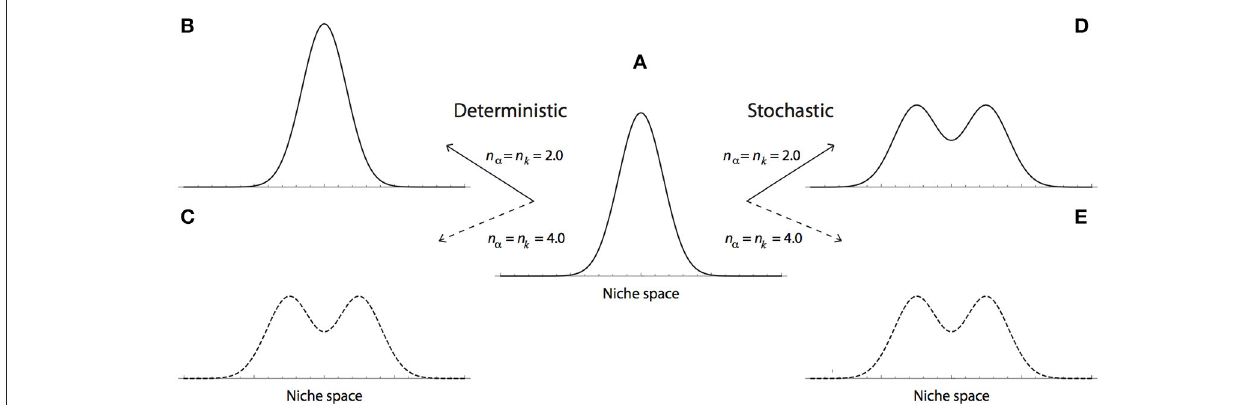
FIGURE 1 | Deterministic vs. stochastic evolutionary dynamics of the Lotka-Volterra competition model. The evolutionary dynamics of the LVC model under a regime of frequency-dependent selection (i.e., a > k ); with either deterministic (B,C) , or stochastic (D,E) environmental conditions. Under these conditions, the model leads to two possible evolutionary outcomes, which depend on the relation between the shape parameters of the competition and carrying capacity functions ( n α and n k ). The maintenance of phenotypic diversity and evolutionary branching, are illustrated by a unimodal and bimodal phenotypic distributions, respectively. (A) Initial, bell-shaped distribution of phenotypic diversity, φ ( x , t 0). (B,C) Under deterministic conditions, evolutionary branching is not a granted = n k outcome of the LVC model. (B) In the case of Gaussian functions ( n α 2.0), the model predicts the maintenance of phenotypic diversity. (C) When the carrying = = n k = 4.0), stabilizing selection remains if: k > a . However, if k < a , frequency-dependent selection leads to capacity and competition functions are quartic ( n α = branching. (D,E) Stochastic fluctuations lead to branching even in the Gaussian case. (D) Under stochastic conditions, even Gaussian competition and carrying n k = 2.0), lead to evolutionary branching. (E) As in the deterministic case, when the carrying capacity and competition functions are quartic capacity functions ( n α = n k = 4.0), the model leads to branching. Both axes are in arbitrary ( n α =